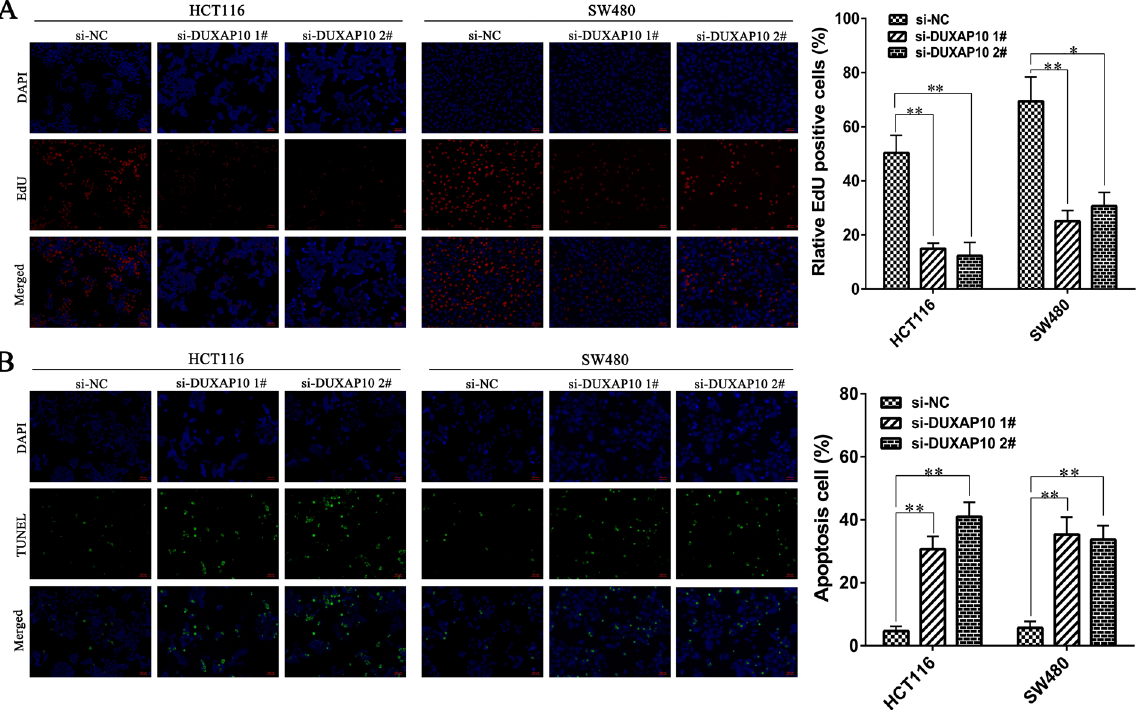
Figure 4. Effect of DUXAP10 on CRC cell proliferation and apoptosis confirmed by Edu analysis and TUNEL assay. ( A ) Proliferating HCT116 and SW480 cells were labeled with Edu. The Click-it reaction revealed Edu staining (red). Cell nuclei were stained with DAPI (blue). ( B ) TUNEL staining assays were performed to analyze cell apoptosis after DUXAP10 knockdown. The images of TUNEL positive cells were captured by a fluorescence microscope (200 × ). Quantitative result of TUNEL assay was analyzed. Representative images and data based on three independent experiments. Bars: s.d, * P < 0.05, ** P <